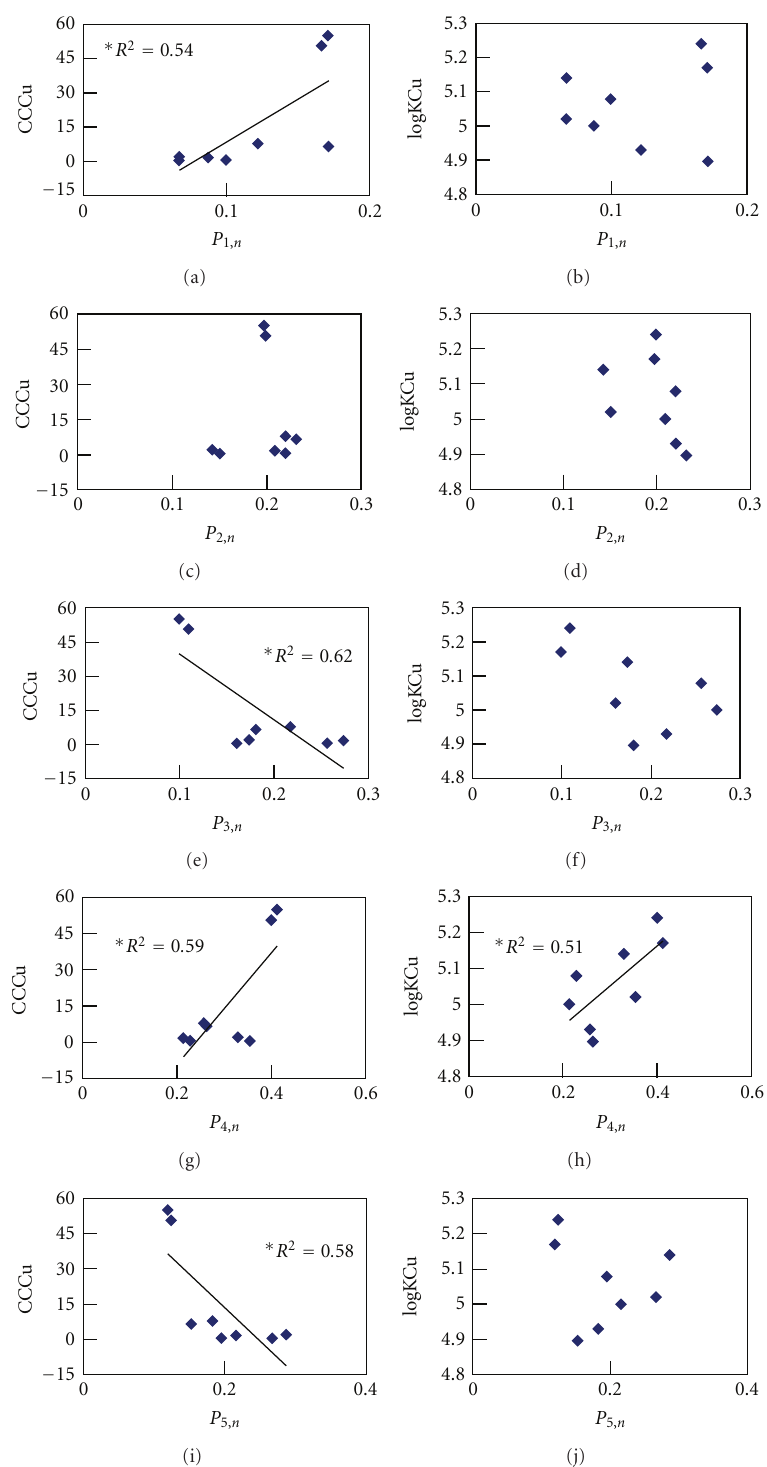
Figure 4: Relationships between percentages of fluorescence response of the five regions ( P i , n ) and complexing capacity (CC Cu ) and the conditional stability constant (log K Cu ) ∗ Statistical significance value P < 0 .